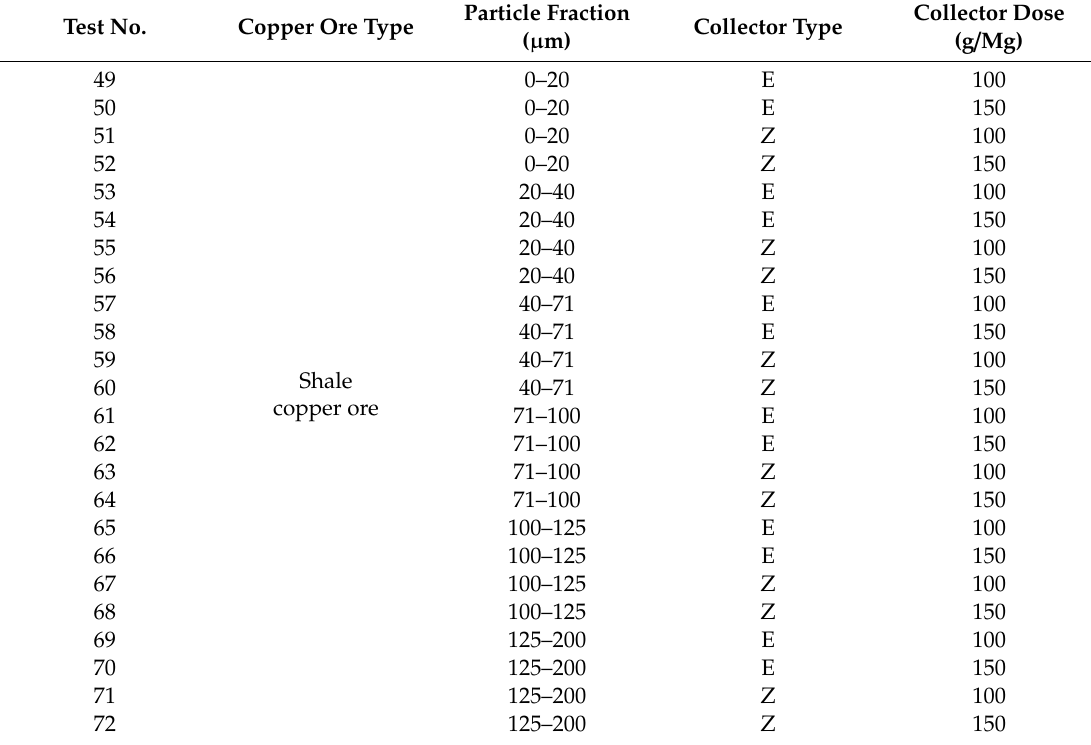
Table 5. The variability range of parameters of the flotation test planned and carried out according to the experimental plan (E—aqueous solution of ethyl sodium xanthate; Z—aqueous solution of isobutyl sodium xanthate)—Denver machine, shale copper ore. Test No.